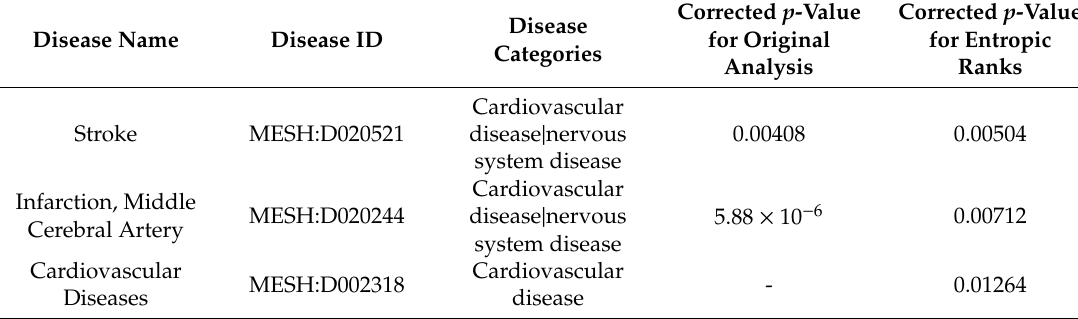
Table 3. GSE12288: Results of the comparison of di ff erentially expressed genes identified by the initial study and entropic ranks with cardiovascular diseases through